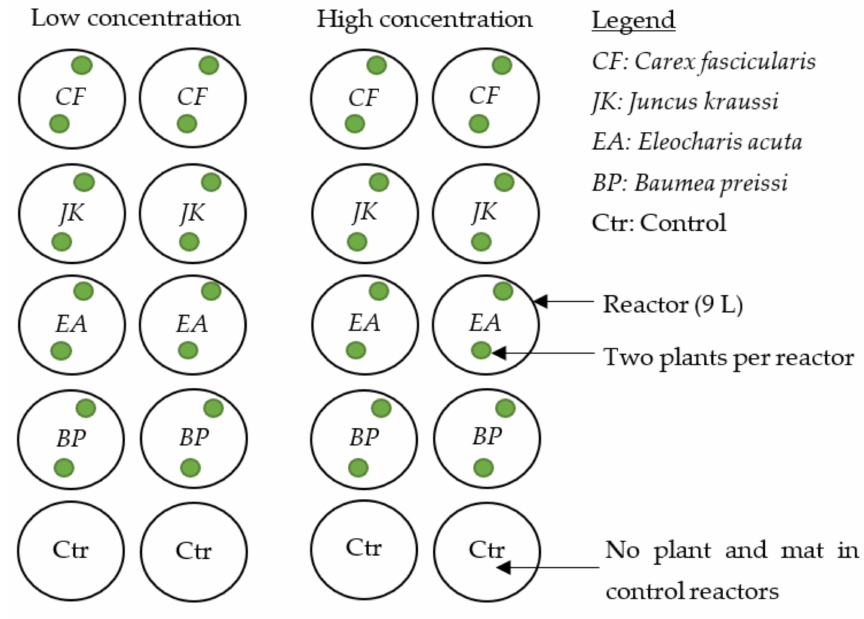
Figure 1. Conceptual diagram of the experimental